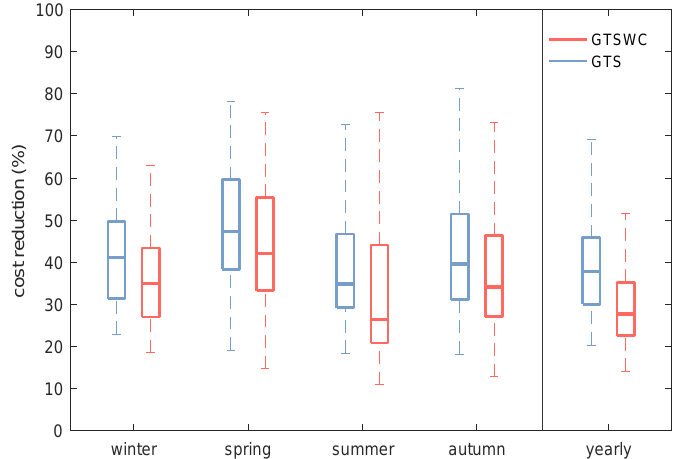
Figure 5. Cost reductions. Statistical analysis of the amount of savings from the electricity bill over various billing periods is presented for the GTS and the GTSWC approaches. The calculation of the unit energy price depends on the aggregated load as introduced in